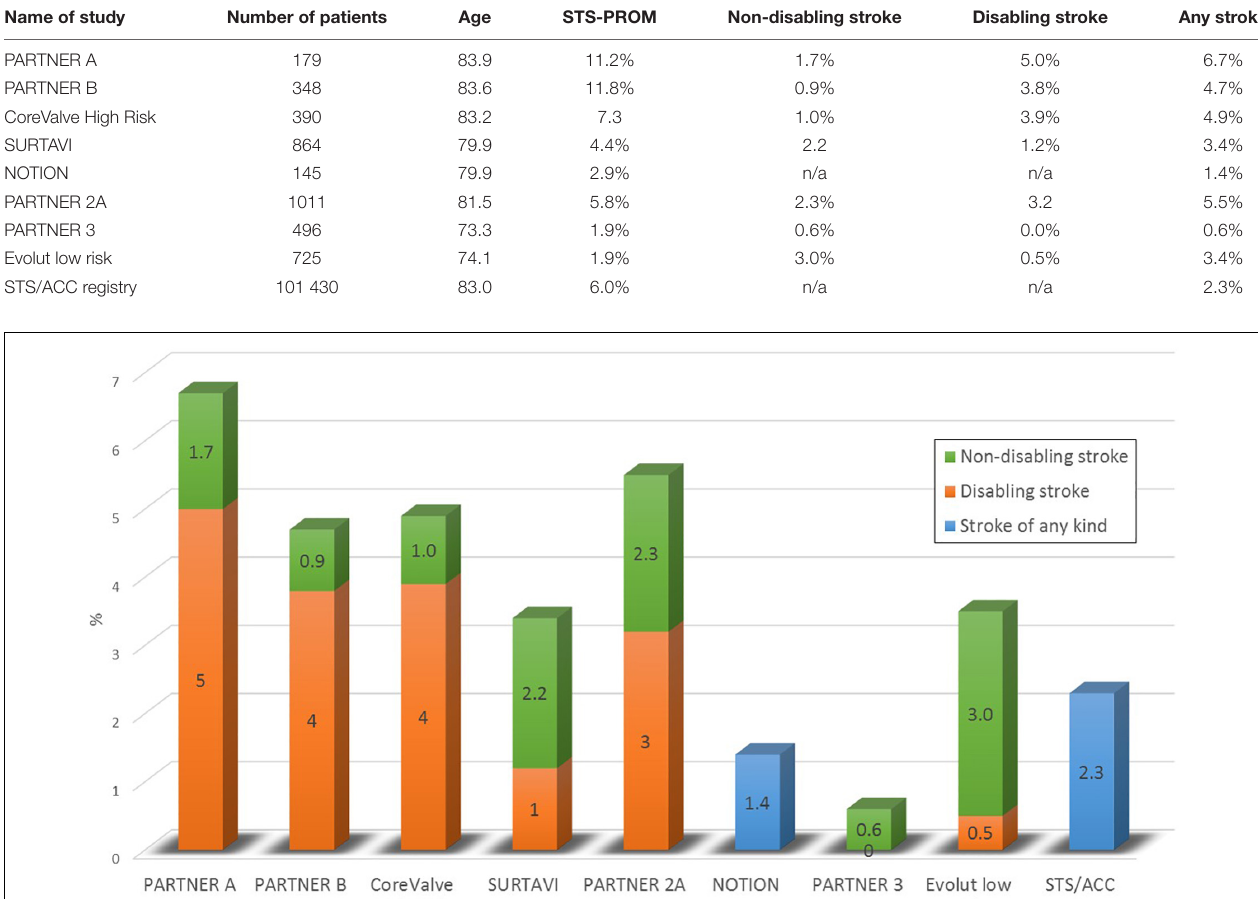
TABLE 1 | Incidence of stroke events at 30 days after TAVI in randomized controlled trials and registries.